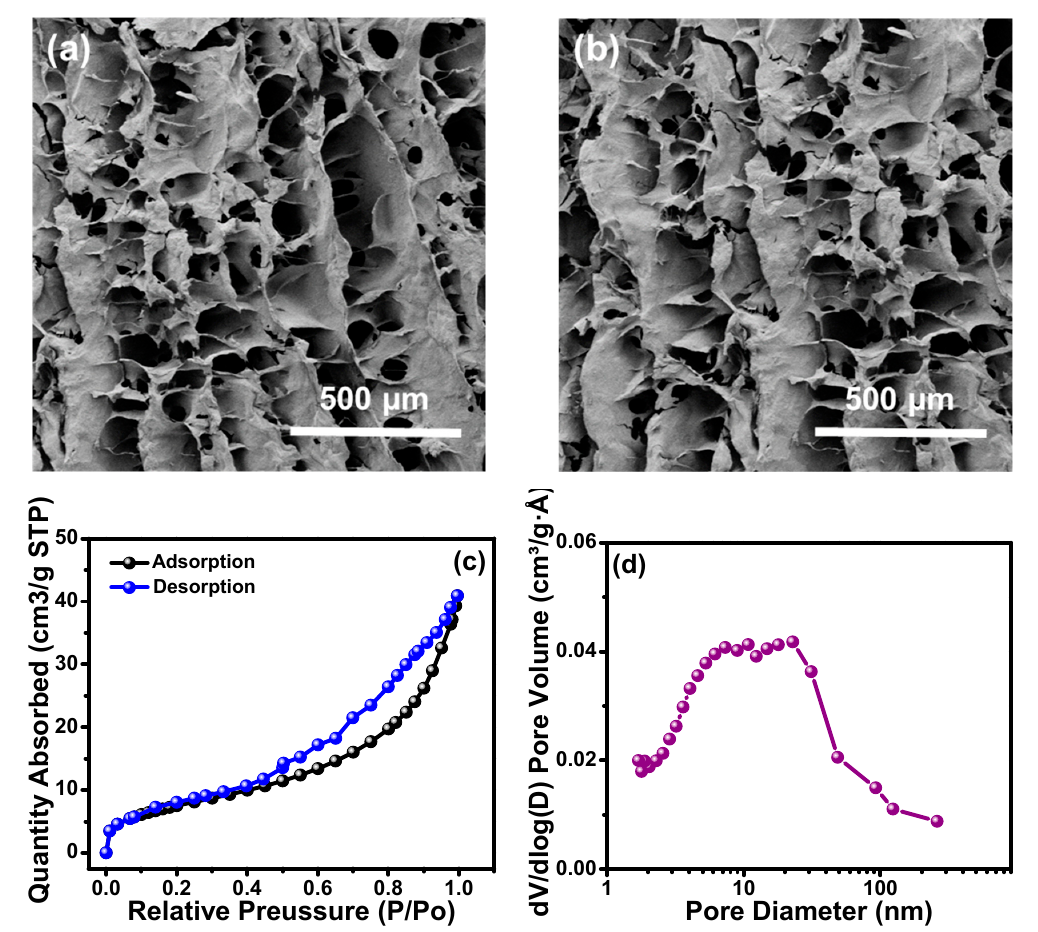
Figure 5. The SEM images of ( a ) unmodified and ( b ) modified aerogels; and the BET measurement of aerogels ( c ) adsorption and desorption, and ( d ) pore size.